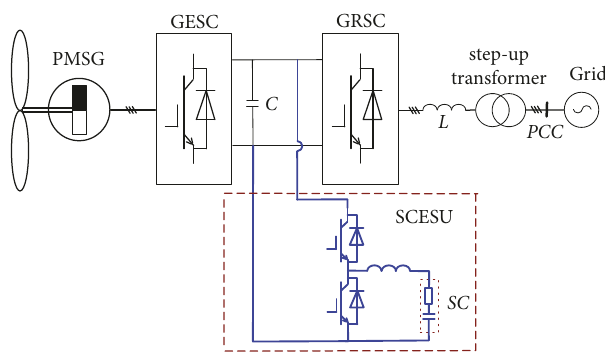
Figure 1: Structure diagram of PMSG-based WTGS with